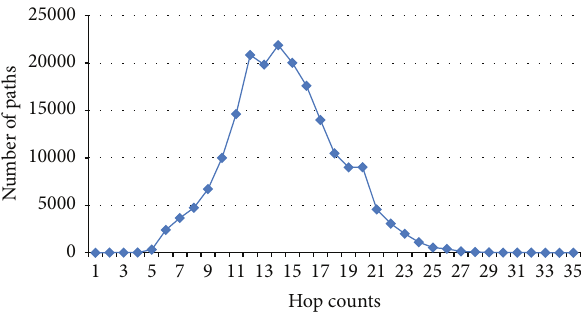
Figure 4: Distribution of path